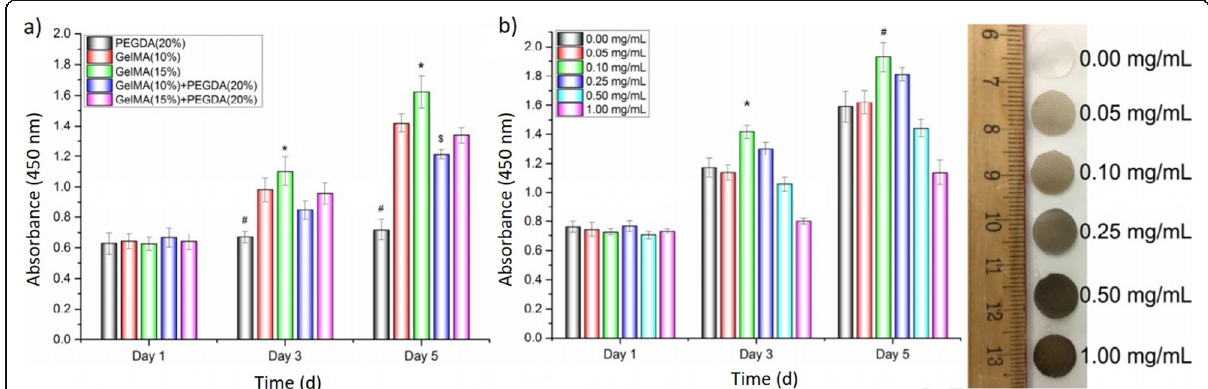
Fig. 11 a Evolution along 5 days of MSCs proliferation on hydrogels with different compositions. b MSCs proliferation on scaffolds with GelMA- PEGDA and different concentrations of GO for 5 days. The photographs represent the corresponding scaffolds. Reproduced with permission from [109]